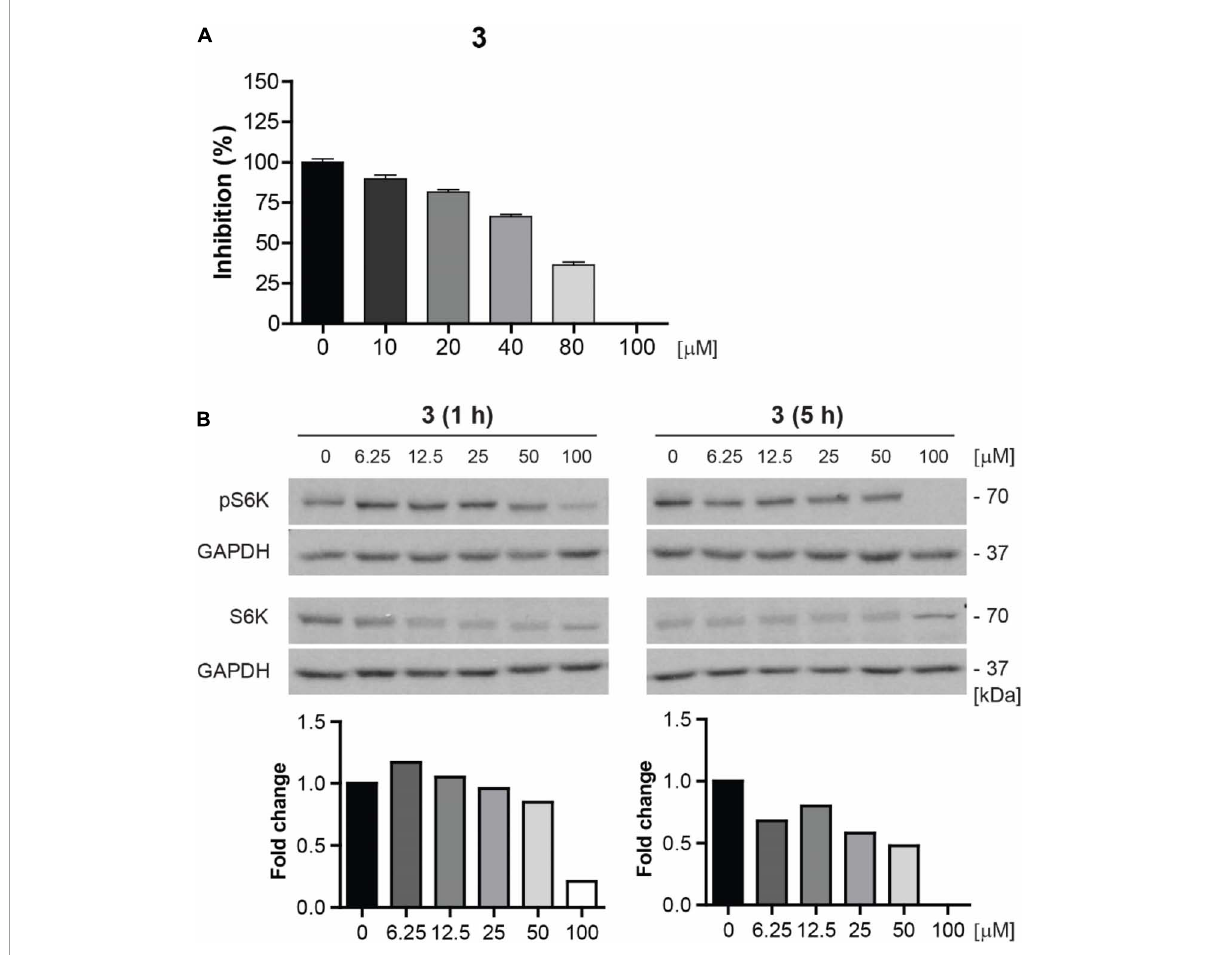
FIGURE9 Compound 3 is the direct inhibitor of mTORC1 kinase. (A) In vitro mTOR kinase enzyme assay of compound 3 tested in the concentration range of 0–100 µ M. The percentage of mTOR kinase activity inhibition is plotted. (B) Inhibition of mTORC1 kinase activity assayed in BJ cells after 1- and 5-h-long exposure to compound 3 (0–100 µ M) by determination of phosphorylation level of mTORC1 substrate p70 S6K with anti-Thr389 p70 S6K and total p70 S6K antibodies. GAPDH was used as a loading control. Quantitative analysis of immunoblots was done by Image J 1.48v program with GAPDH as the internal